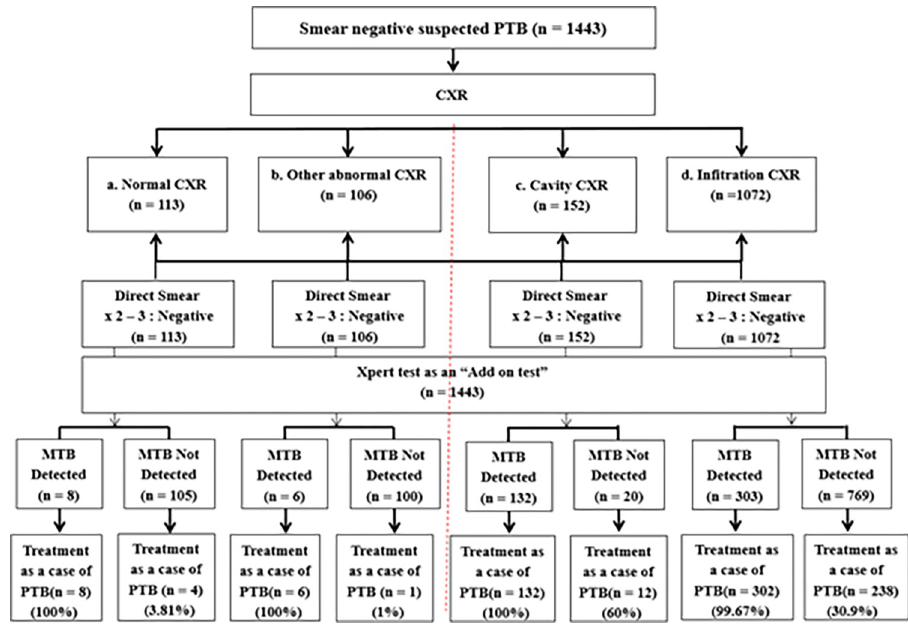
Fig 1. Decision for types of treatments among smear-negative TB suspected cases.